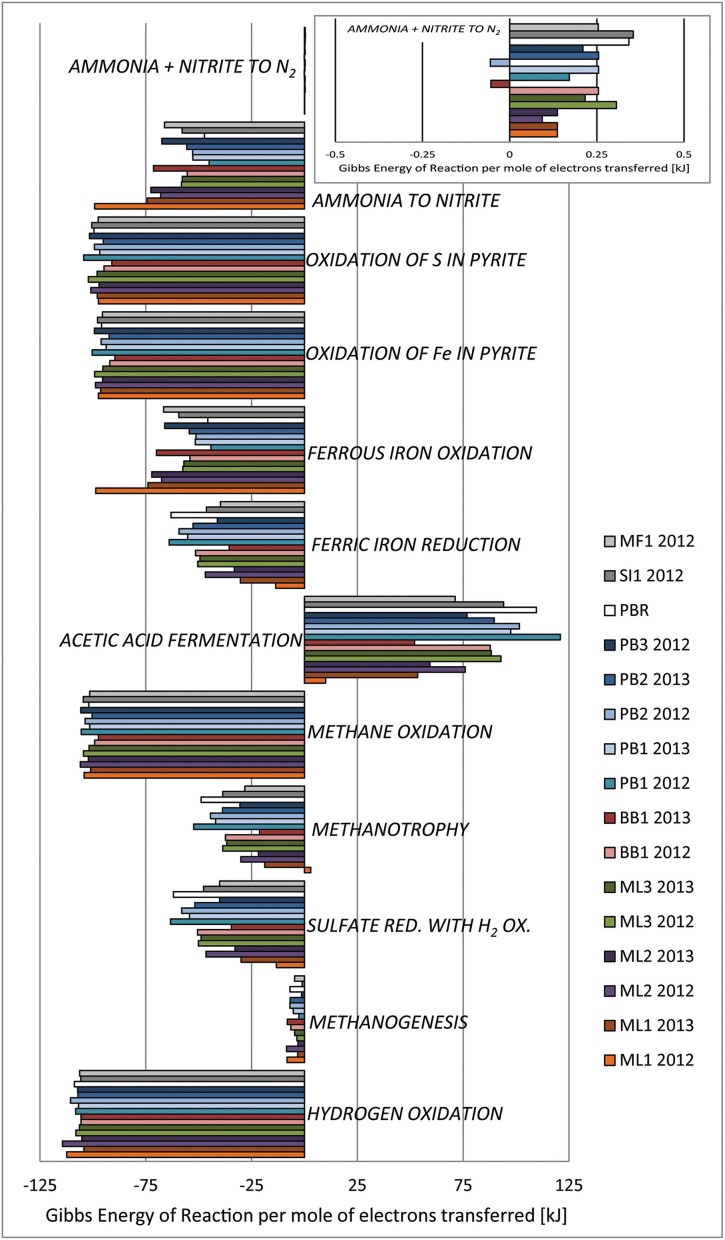
Microbiological metabolic strategies, pitched as chemical reactions, are evaluated for Gibbs energy yield as in Amend and Shock (2001), based on modeled activities derived from environmental data. Recall that spontaneous reactions have ΔGr < 0. The geochemical environments considered here cause shifts in the thermodynamic feasibility of reactions. TDS were estimated from field conductivity data.Hydrogen oxidation: H2(aq) + 0.5O2(aq) = H2O(l)Methanogenesis: CO2(aq) + 4H2(aq) = CH4(aq) + 2H2O(l)Sulfate reduction coupled to hydrogen oxidation: SO2−4 + 4H2(aq) +2H+ = H2S(aq) + 4H2O(l)Methanotrophy: CH4(aq) + SO2−4 + 2H+ = HCO−3 + H2S(aq) + H2O(l)Methane oxidation: CH4(aq) + 2O2(aq) = CO2(aq) + 2H2O(l)Acetic acid disproportionation: acetic acid(aq) = CH4(aq) + CO2(aq)Ferric iron reduction: H2(aq) + 2Fe3+ = 2Fe2+ + 2H+Ferrous iron oxidation: 2Fe2+ + 0.5 O2(aq) + 2H+ = 2Fe3+ + H2O(l)Oxidation of Fe in pyrite: 2 pyrite(s) + 7.5O2(aq) + H2O(l) = 2Fe3+ + 4SO2−4 + 2H+Oxidation of S in pyrite: pyrite + 3.5O2(aq) + H2O(l) = Fe2+ + 2SO2− + 2H+Nitrification: NH3 + 1.5O2(aq) = H+ + NO−2 + H2O(l)Ammonia oxidation: NH3(aq) + NO−2 + H+ = N2(aq) + 2H2O(l).